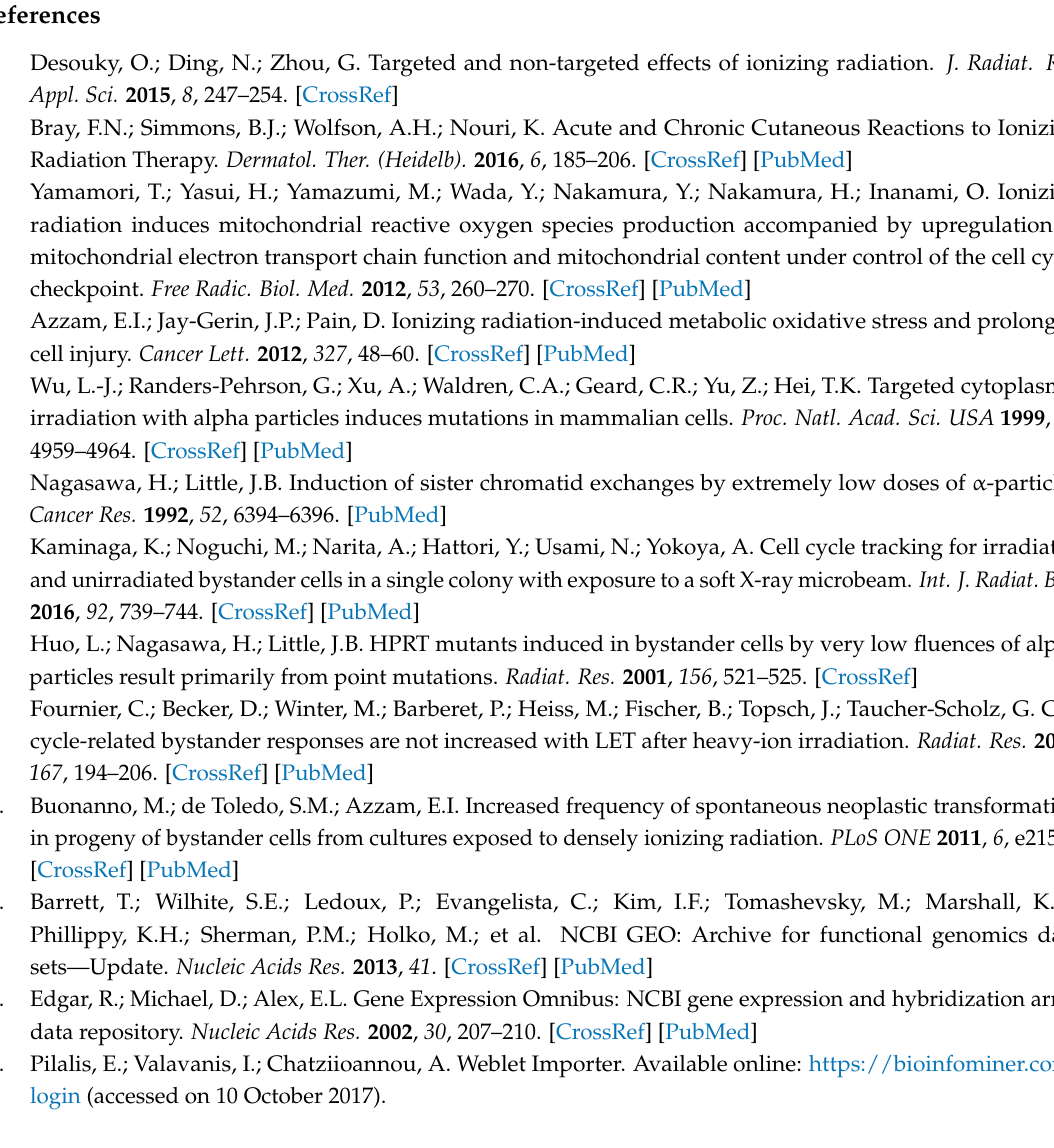
Table S7: Evaluation of differences in Reactome pathways terms of GSE12435 and GSE18760 datasets, Table S8: Evaluation of differences in Reactome pathways terms of dataset